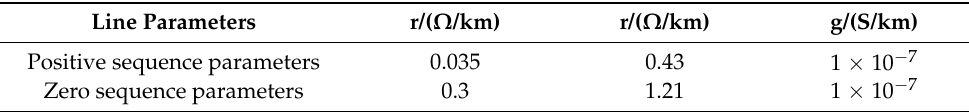
Figure 6. Multi-terminal transmission line fault model. Table 3. Parameters of multi-branch grid-connected lines.